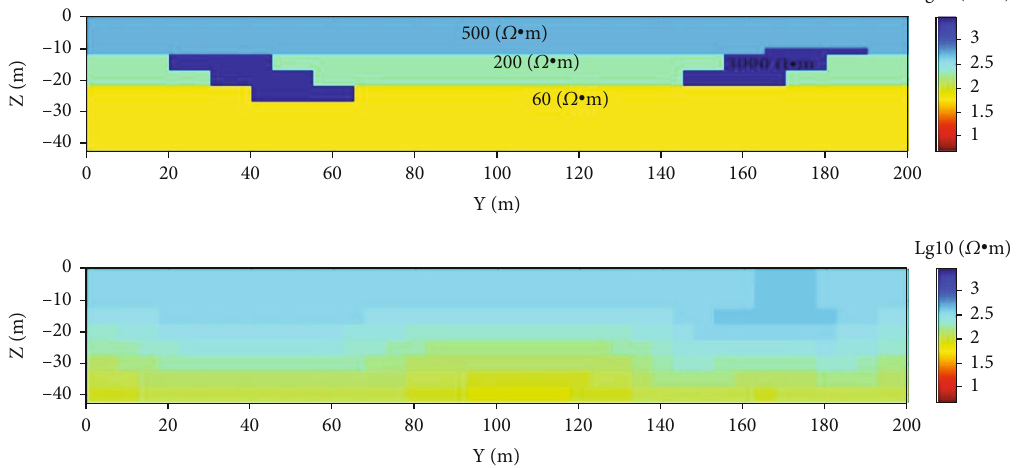
Figure 12: Model of winter and forward simulation results.